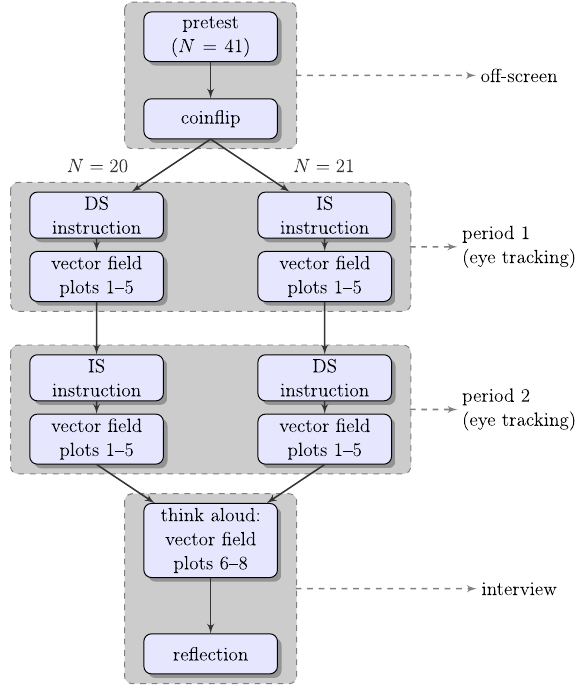
FIG. 3. Study design. During the instruction periods, students first learned one strategy, applied it to five vector fields, and then repeated this procedure with the other strategy. At the end, each student was free to choose one strategy (or both) to solve vector fields V6 – V8 while thinking aloud and commenting about